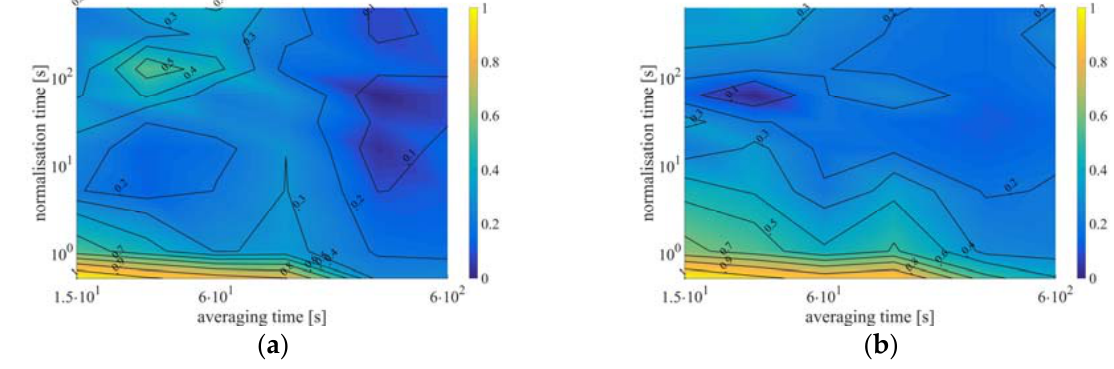
Figure A4. Averaged and normalised error behaviour of the average velocity error, the RMS velocity error, the velocity standard deviation error and the RMS velocity standard deviation error of ( a ) the histogram-based dynamic data filter and ( b ) the Gaussian kernel based dynamic data filter. Staring mode LiDAR data from 04.01.2014 7:30 h (UTC) till 05.01.2014 7:30 h (UTC) form the basis for this calculation.